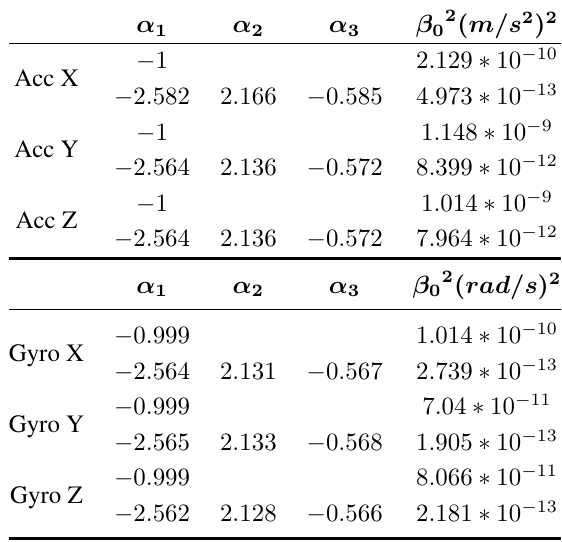
Table 2. Autoregressive process coefficients for each inertial sensor obtained with Burg’s method after wavelet de-noising with six